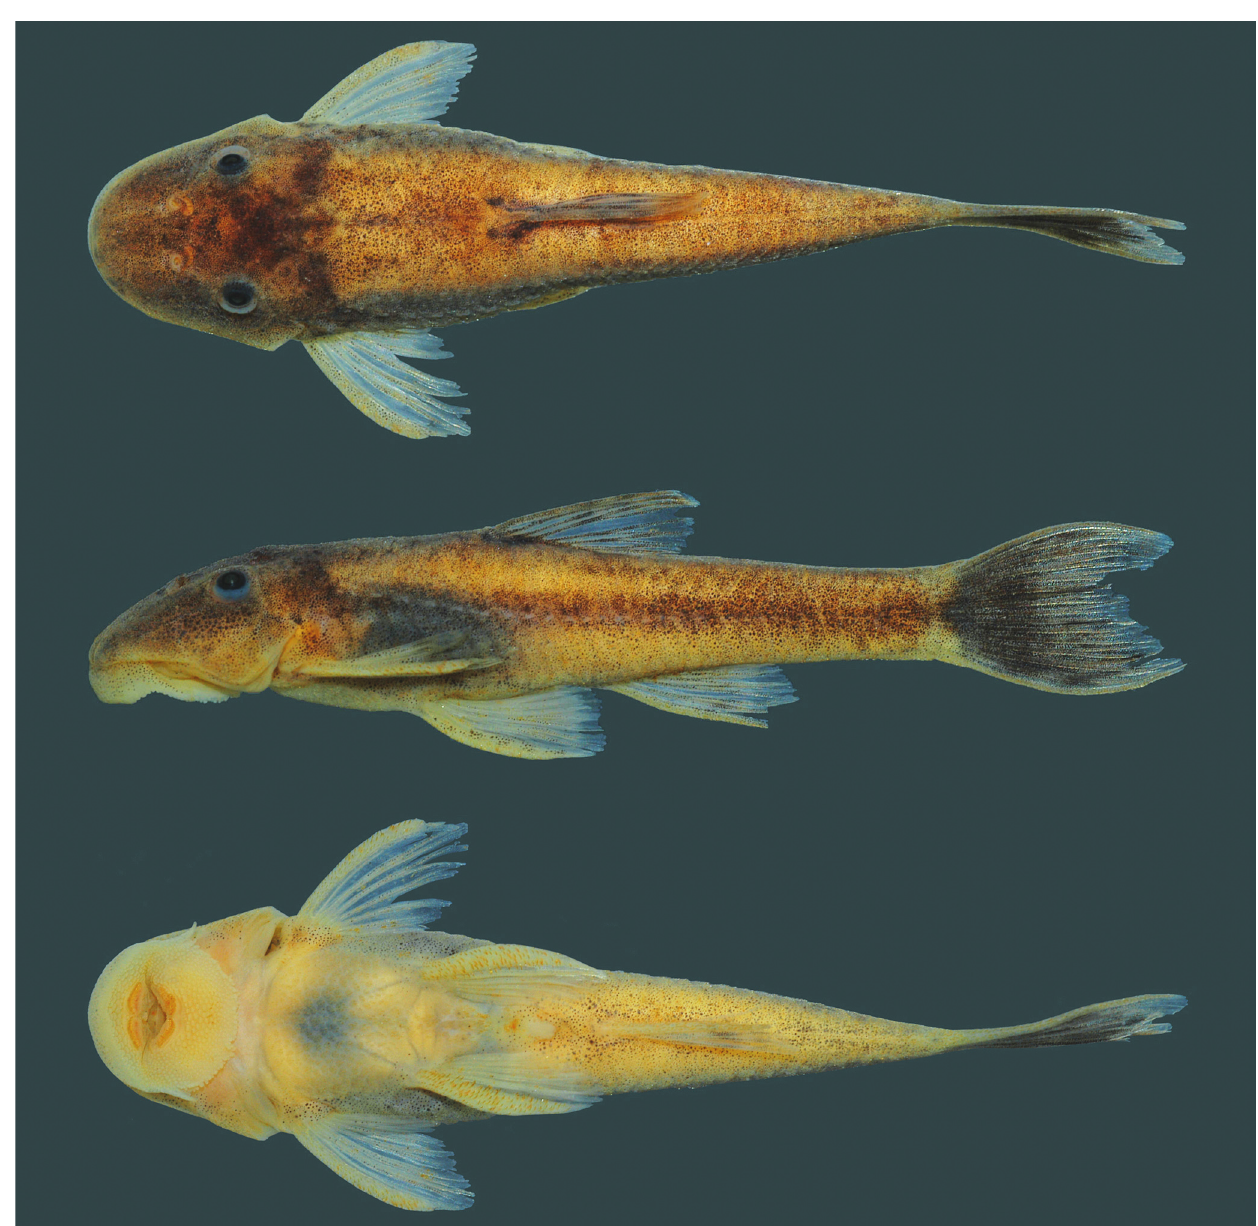
Caldas Novas, Goiás State,